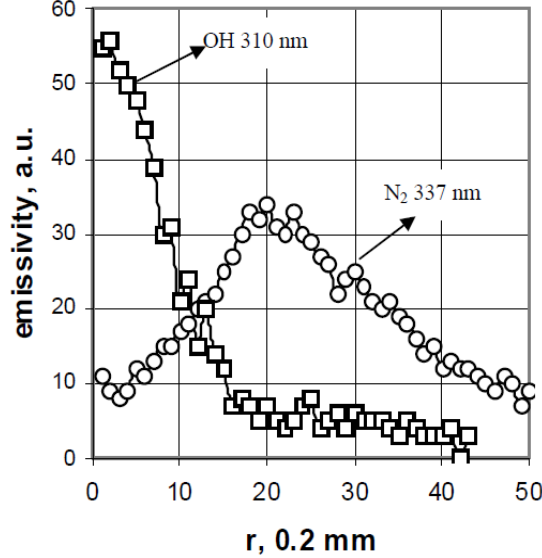
Figure 2. The radial distribution of the emitted intensity of OH 310 nm (squares) and the N 337 nm (circles) in the negative glow region of a typical ELCAD discharge (I = 67 mA, 2 tap water, pH = 1.55)